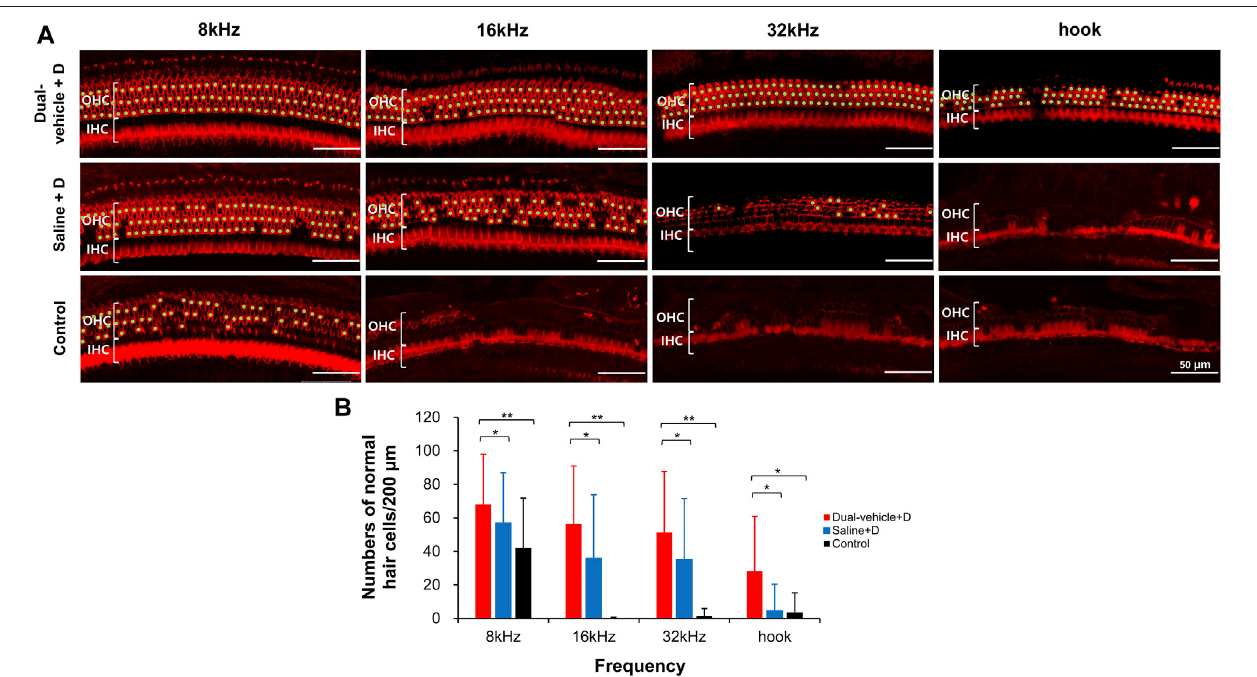
FIGURE5 | Numberof outer hair cells in theapical turn(8 kHz), middle turn (16 kHz), basalturn (32 kHz), and hookportion.Signi fi cantlymore outer hair cells were observed in the dual-vehicle + D group than in the saline + D or control group (B) . This fi nding was consistent along the entire length of the cochlea spiral. Live hair cells were marked with a light green dot (A) . * p < 0.05, ** p < 0.01. IHC, inner hair cell; OHC, outer hair cell. Scale bars represent 50 µm.